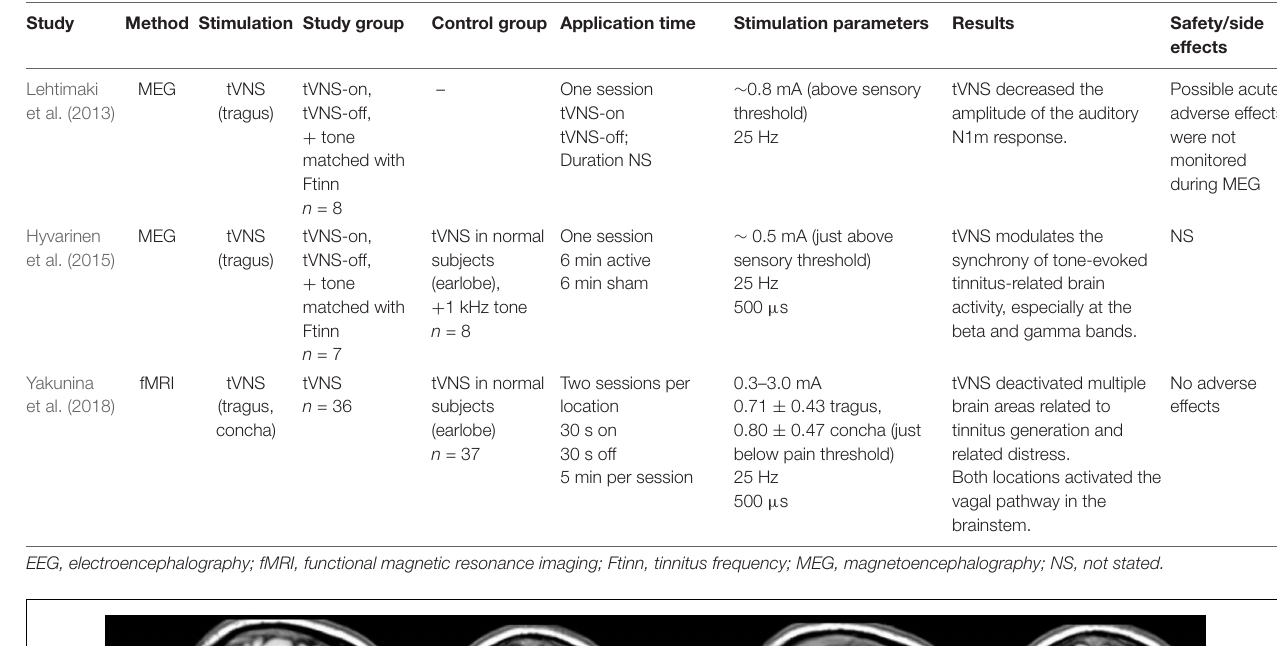
TABLE 2 | Summary of neuroimaging studies on (t)VNS in patients with tinnitus.